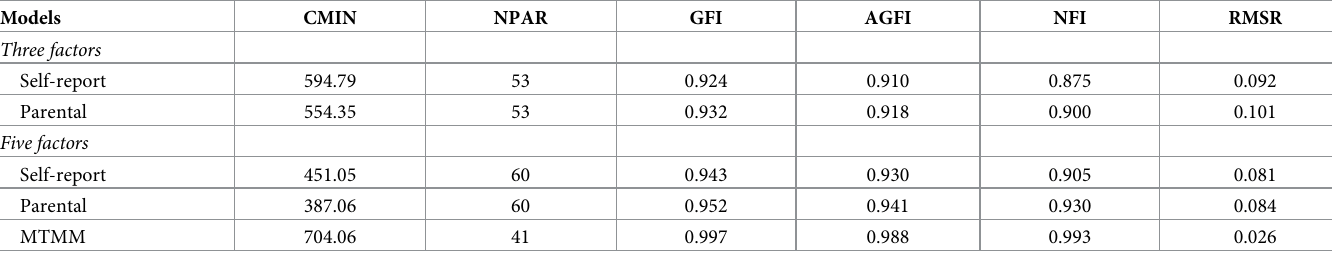
Table 2. Confirmatory factor analysis of the